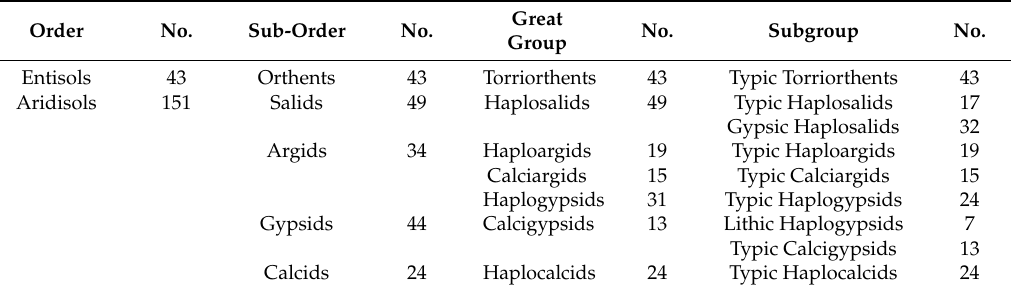
Table 1. Soil types observed in the study